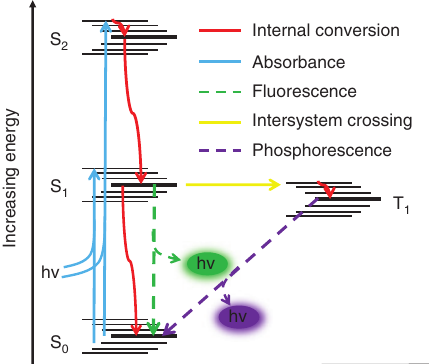
Figure 4: Jablonski diagram showing fluorescence and competing pathways for molecular relaxation from an excited state. Reproduced with permission from